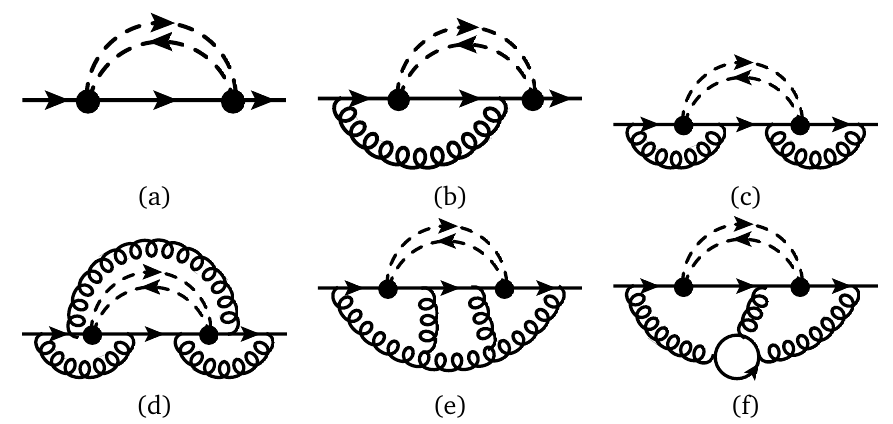
Figure 1: Sample Feynman diagrams which contribute to the forward scattering am- plitude of a bottom quark at LO (a), NLO (b), NNLO (c) and N 3 LO (d-f). Straight, curly and dashed lines represent quarks, gluons and leptons, respectively. The weak interaction mediated by the W boson is shown as a